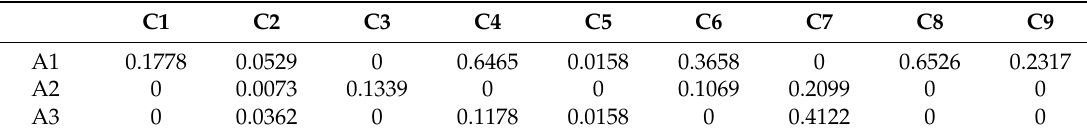
Table 6. The calculation results of ∆ −